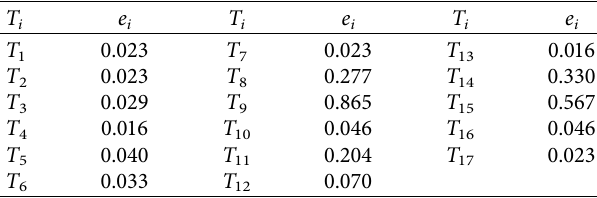
Table 5: Table of sensitivity coefficients of SPN model.